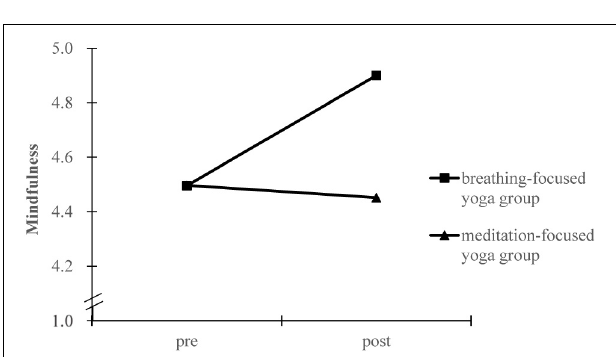
FIGURE 2 | Marginal means estimated for mindfulness before and after intervention by group.